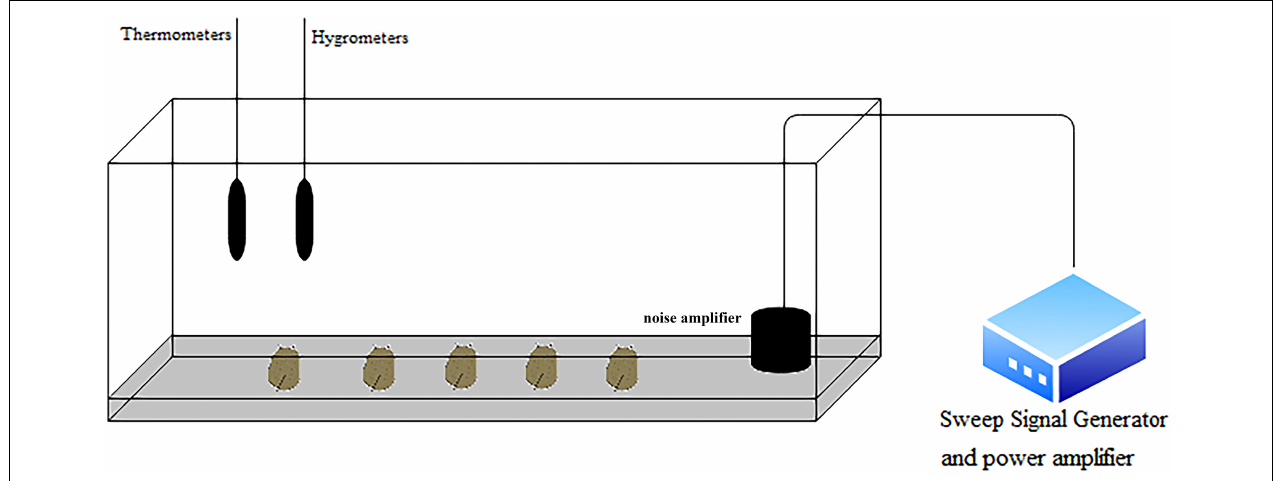
FIGURE 1 | Schematic diagram of the experimental device. The sea slug is at the bottom of the tank. The noise amplifier is located on the right side of the tank. The thermometer and hygrometer are placed on the wall of the tank. The signal generator and power amplifier are located outside the